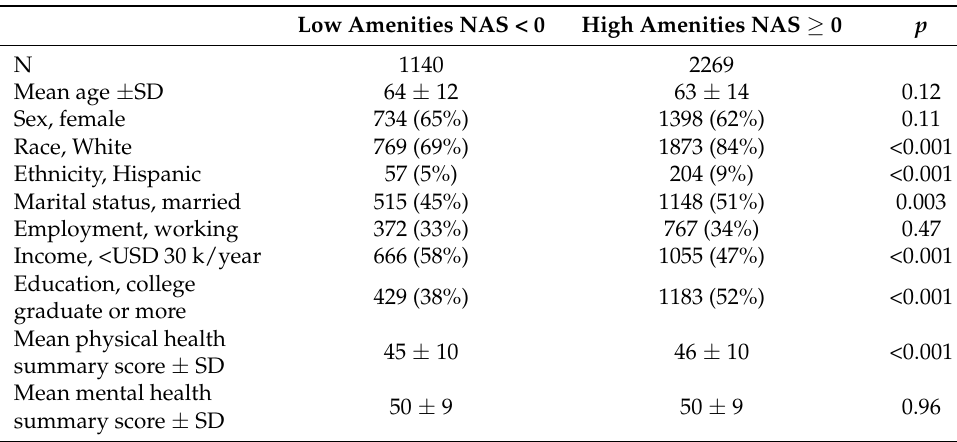
Table 1. Participant characteristics stratified by the natural amenities scale. Low Amenities NAS <